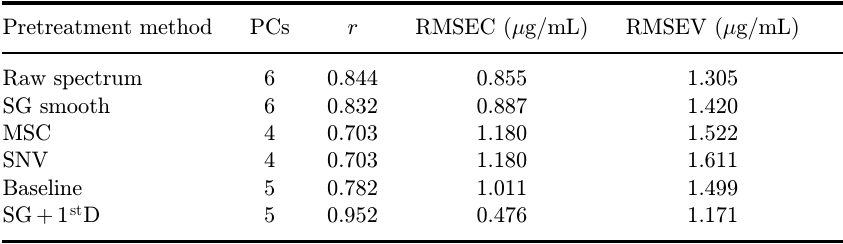
Table 4. Performance comparison of PLS Models by di®erent spectral pretreatments.